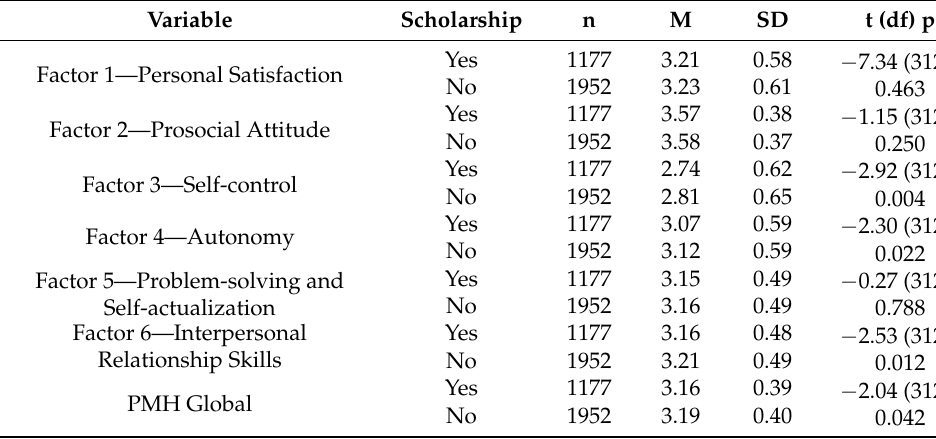
Table 8. Student’s t -test for scholarship and